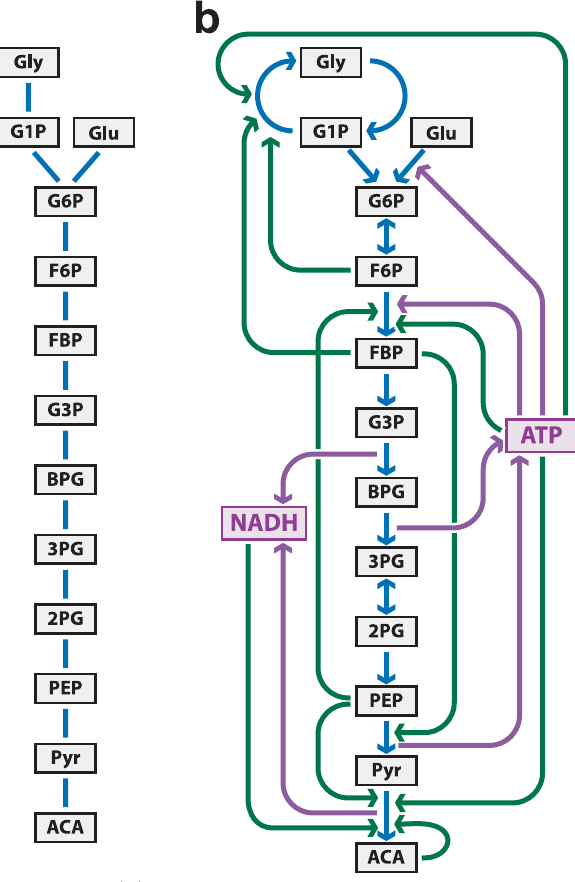
Figure 3. Cartoons of a Generic Glycolysis Network in Bacteria (A) A simple graph showing the main metabolites of glycolysis and their relationships. (B) The same metabolites but also including reactions (solid blue lines), autocatalytic feedbacks (solid purple lines), and regulatory feedbacks (dotted black